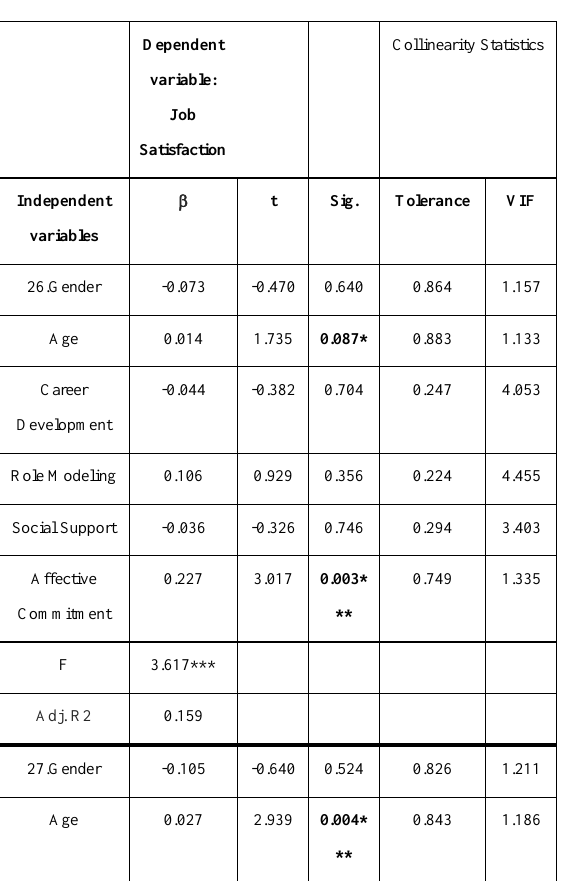
Table 12.The Effect of Mentoring and